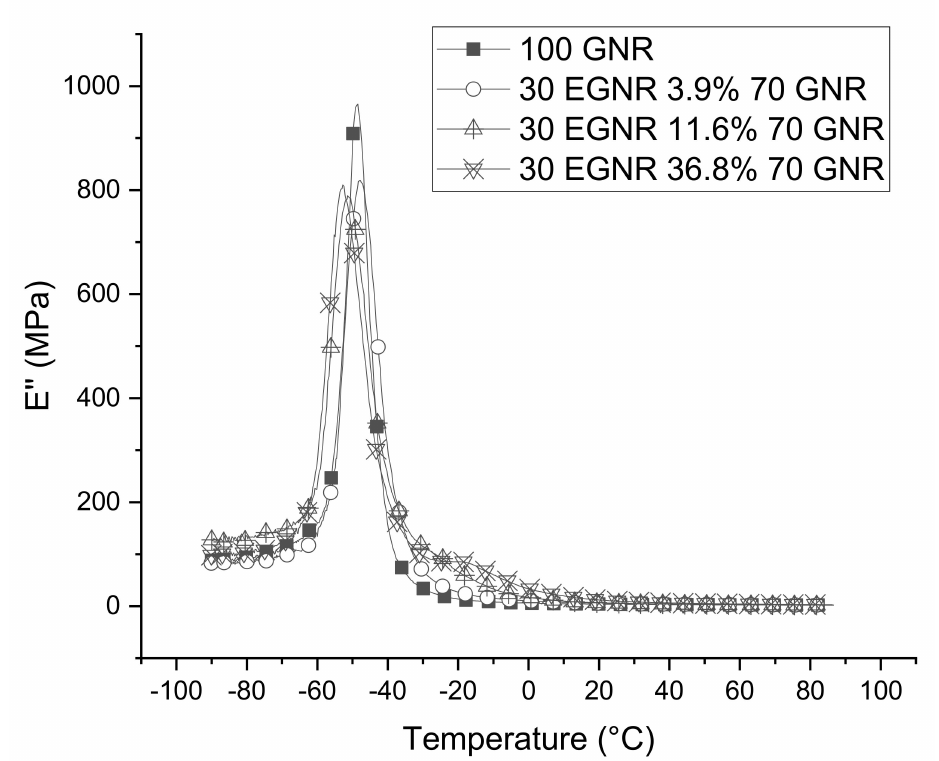
Figure 8. Loss modulus (E”) of guayule natural rubber/epoxidized guayule natural rubber blend composites with various epoxide fractions. GNR 50CB: guayule natural rubber composites without epoxidation; 30EGNR 3.9% 70GNR 50CB: guayule natural rubber/epoxidized guayule natural rubber blend composites with 3.9% epoxide fraction; 30EGNR 11.6% 70GNR 50CB: guayule natural rubber/epoxidized guayule natural rubber blend composites with 11.6% epoxide fraction; 30EGNR 36.8% 70GNR 50CB: guayule natural rubber/epoxidized guayule natural rubber blend composites with 36.8% epoxide